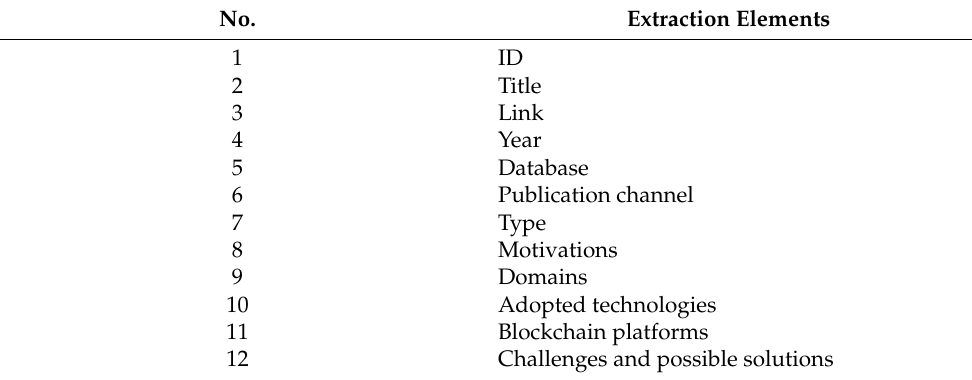
Table 4. The data extraction form.